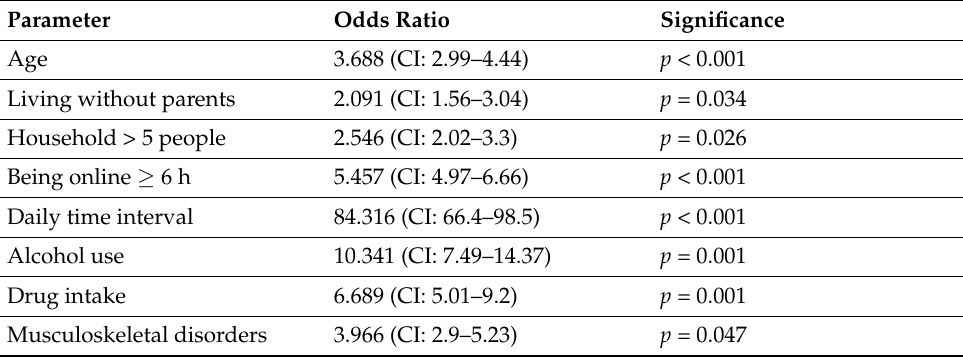
Table 7. Risk factors associated with internet addiction in a multivariate